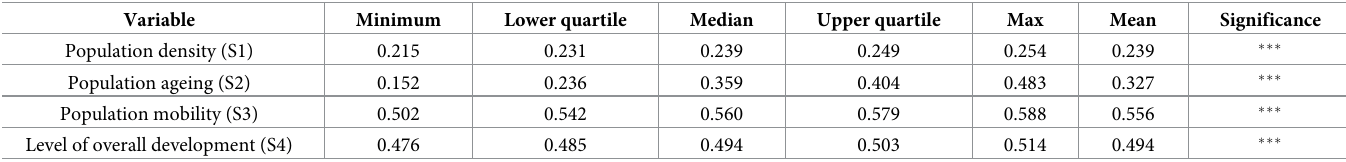
Table 4. Calculation result statistics of the GWR model for socioeconomic attributes.